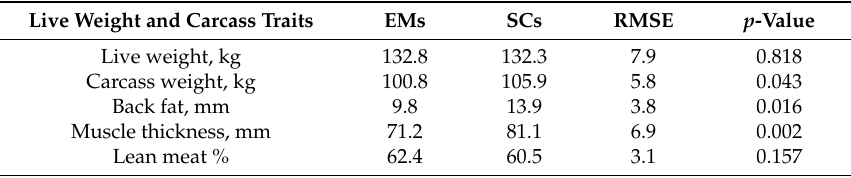
Table 1. Live weight and carcass traits of pigs included in the study according to sex group. Live Weight and Carcass